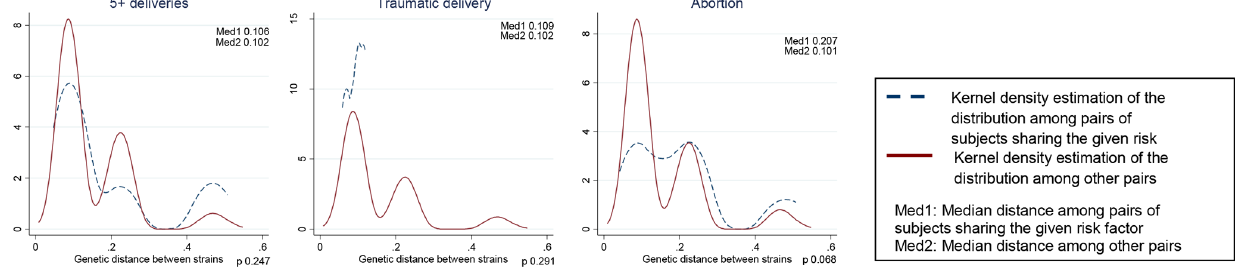
Figure 4. Distributions of viral genetic distances depending on obstetric risk factors (n=55). Same interpretation as for Figure 2.